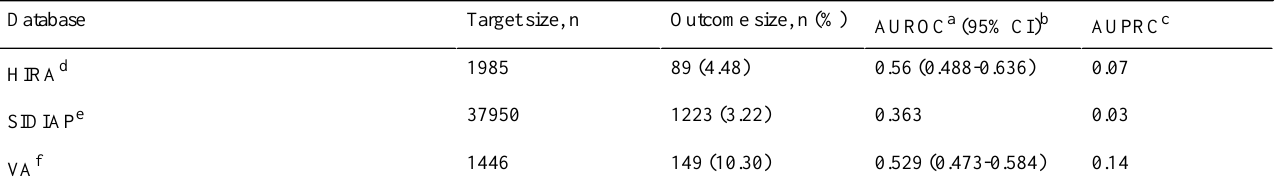
Table 2. External validation of the COVID-19 vulnerability index model on COVID-19 data. The target cohort was patients with an outpatient or emergency department visit with a COVID-19–positive record in 2020 and no symptoms in the prior 60 days.